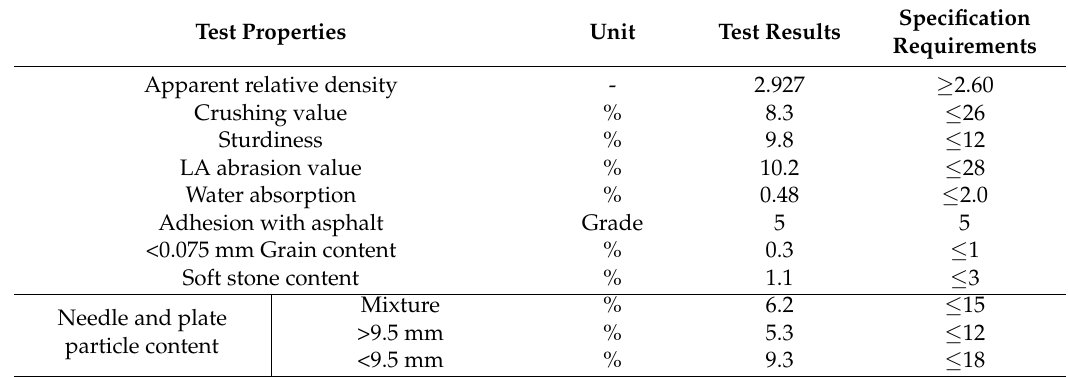
Table 2. Technical indicators of coarse aggregate.